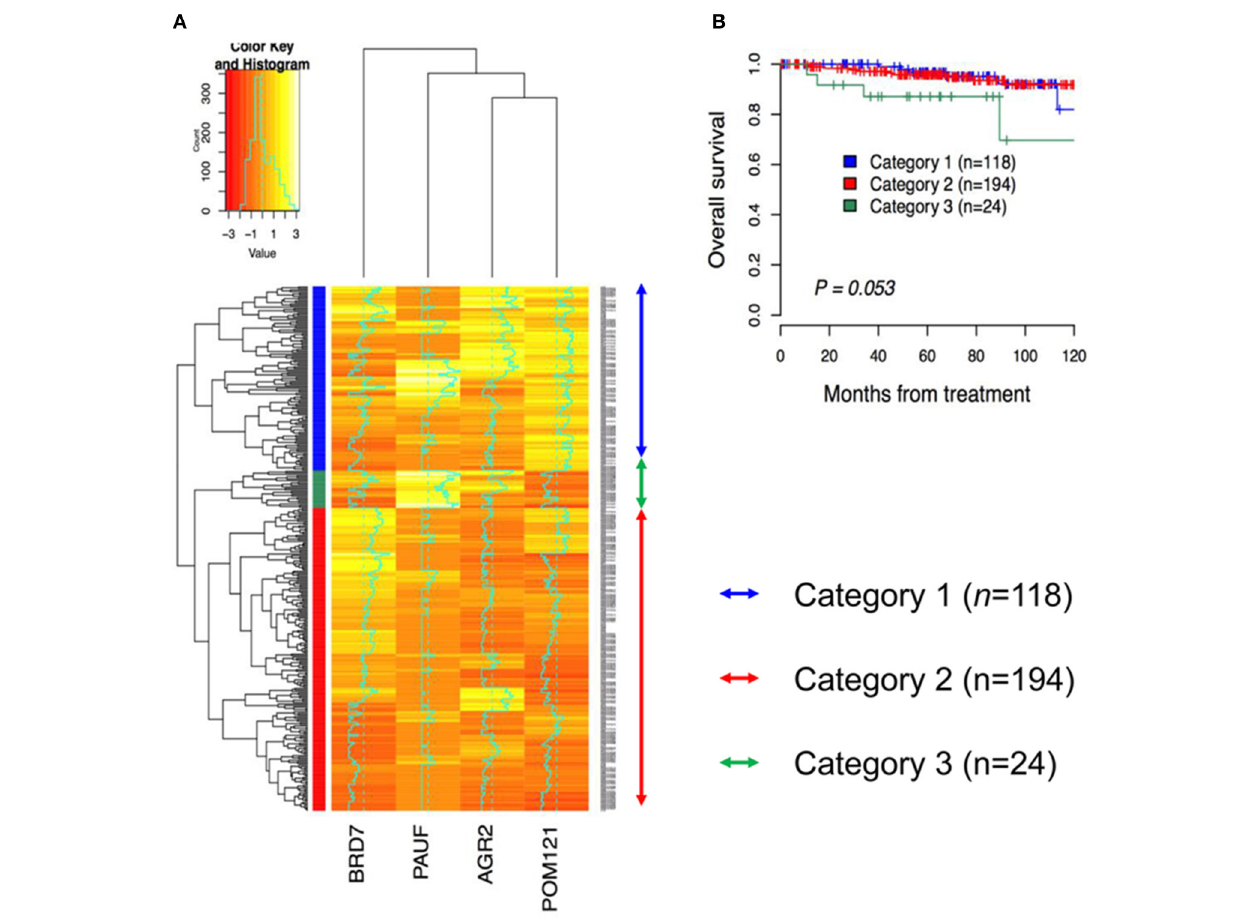
FIGURE 3 | Hierarchical clustering analysis for immunohistochemical expression of PAUF-associated proteins in cervical cancer patients. (A) Three cluster groups were identified in the present study. Category 1 ( n = 118, blue arrow) consists of relatively high AGR2 and POM121 expression. Category 2 ( n = 194, red arrow) consists of relatively low AGR2 and PAUF expression. Category 3 ( n = 24, green arrow) consists of relatively high PAUF and low POM121 expression. (B) Kaplan–Meier plot for overall survival according to group by hierarchical clustering. A tendency toward decreased overall survival was observed in Category 3 than in the other groups ( log -rank test, p =